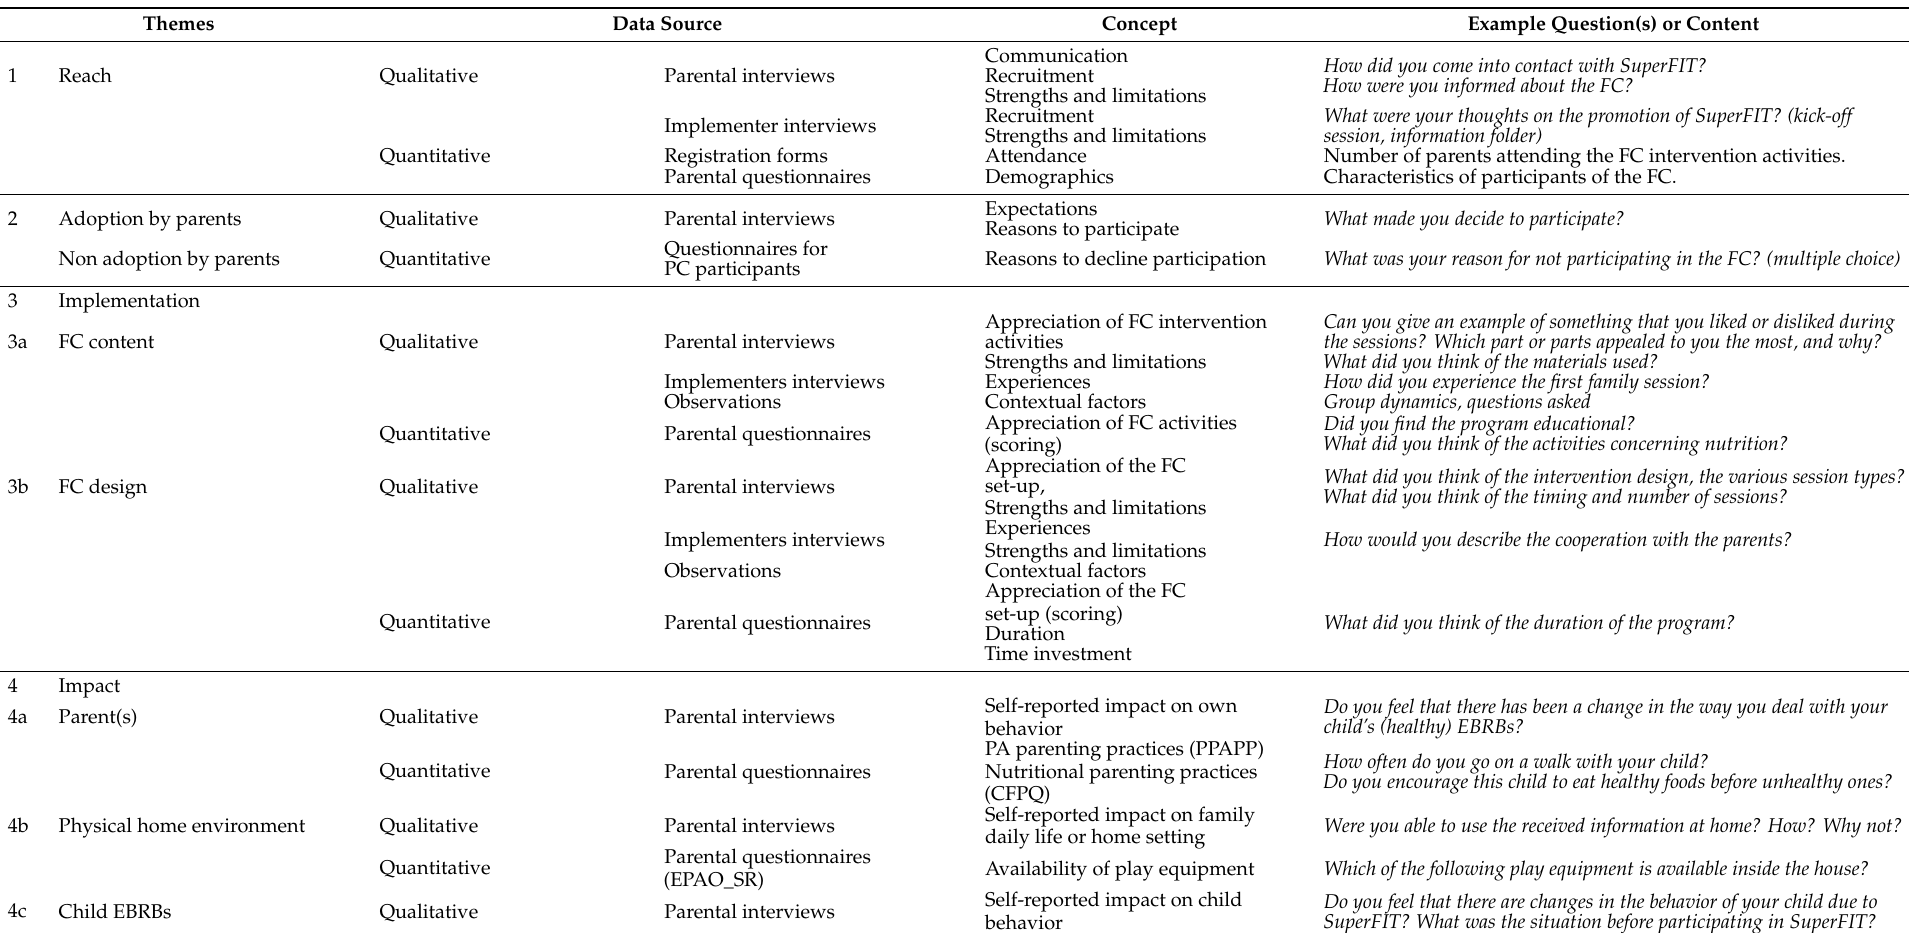
Table 1. Thematic structure of the present